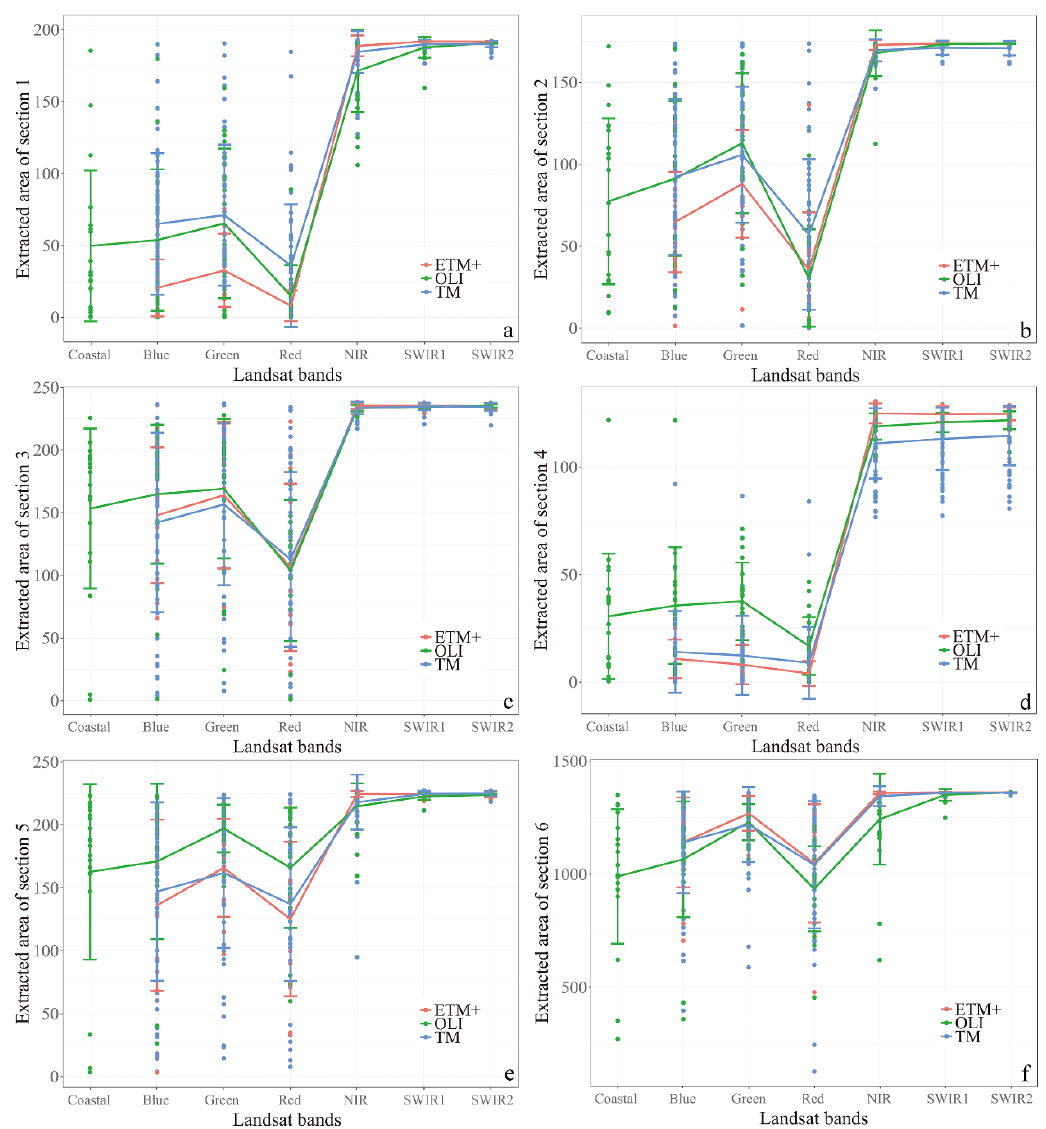
Figure 10. Water extraction among Taihu sections using Landsat bands. Water extraction results of section 1 ( a ), section 2 ( b ), section 3 ( c ), section 4 ( d ), section 5 ( e ) and section 6 ( f ) in Taihu Lake based on different Landsat bands from three sensors from Landsat series (TM = Thematic Mapper; ETM + = Enhanced Thematic Mapper ; OLI = Operational Land Imager; NIR = near-infrared band; SWIR1 = first shortwave-infrared band; SWIR2 = second shortwave-infrared band ) .